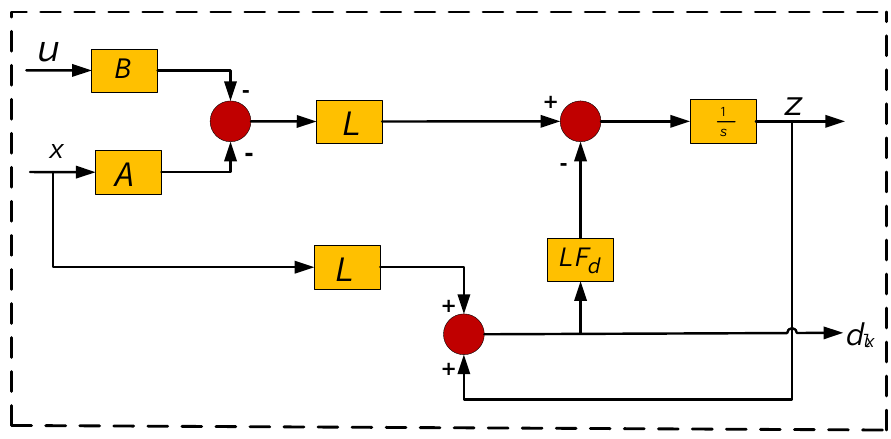
Figure 3. Disturbance observer block-diagram.